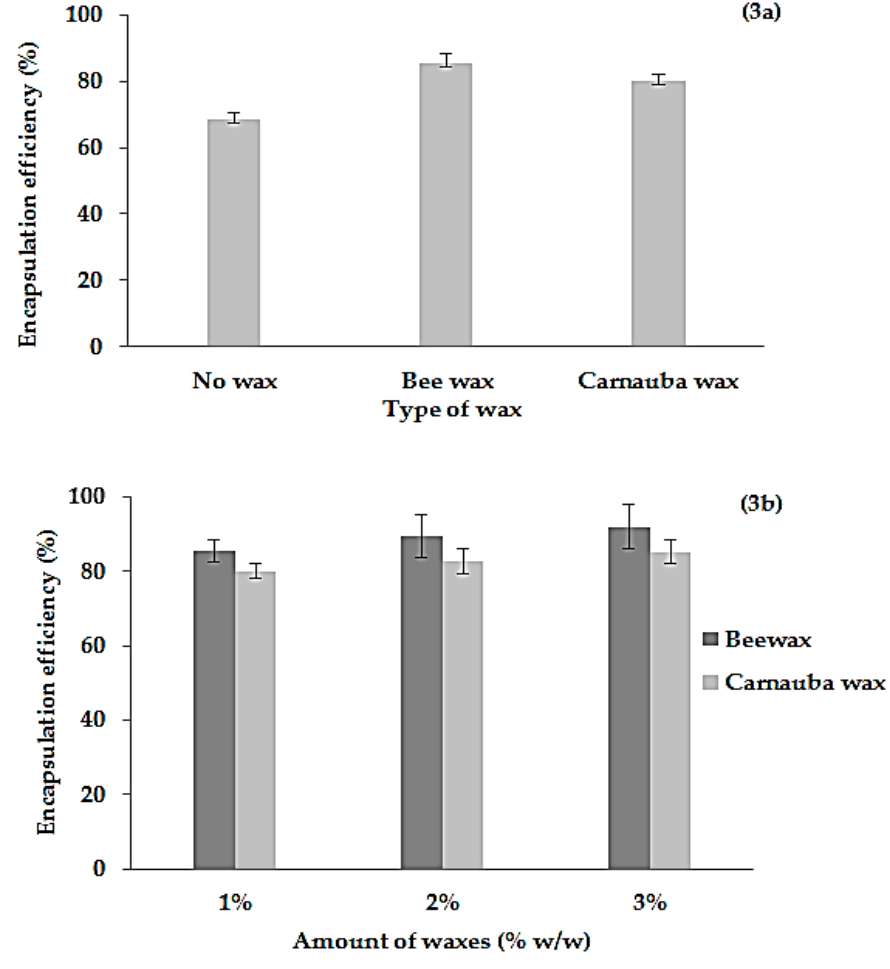
Figure 3 . Effect of different types ( 3a ) and amounts ( 3b ) of waxes on the percentage of encapsulation efficacy of emulsion gel beads containing tamarind seed extract.